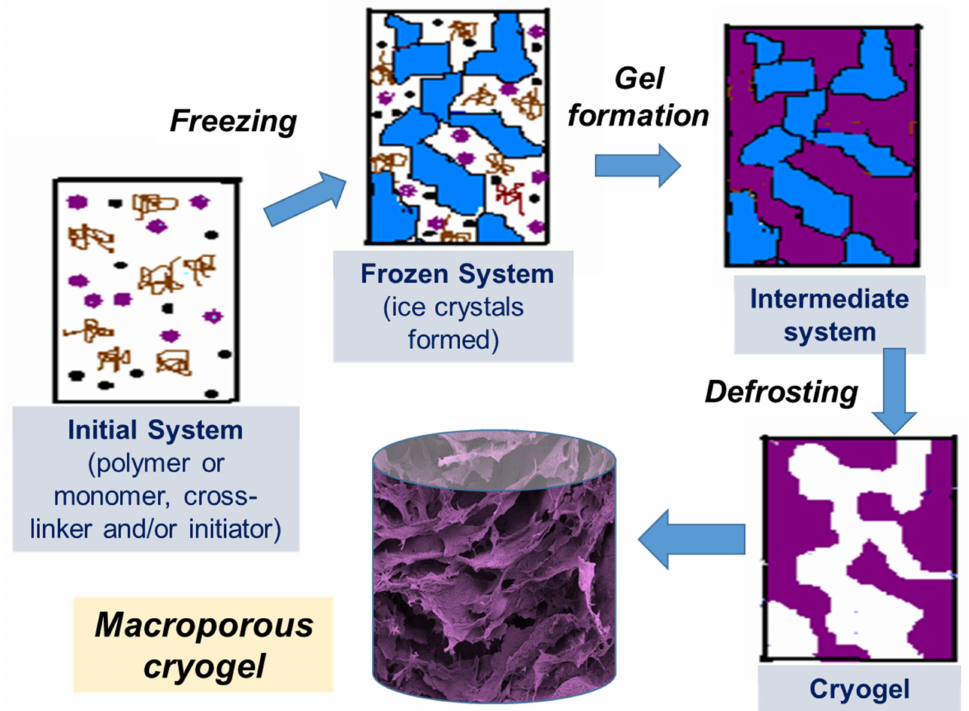
Figure 1. Scheme of preparation of cryogels: (i) initial system (the gel precursor solution is cooled down to a temperature below freezing point); (ii) frozen system (the ice crystals formed and solutes are concentrated in non-frozen zones); (iii) intermediate system (gel is formed in non-frozen liquid around ice crystals); (iv) cryogel is formed upon